Question: Write a caption explaining this figure to a reader.
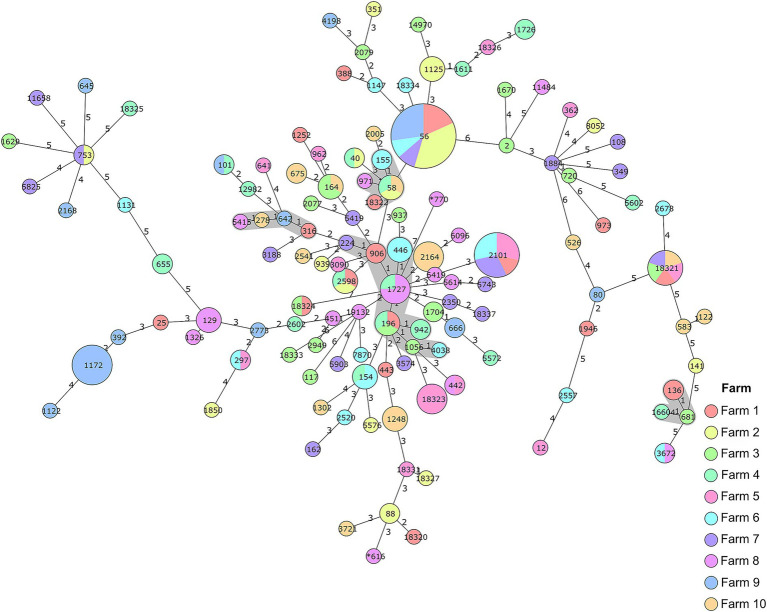
Answer: Proportion of non-wild-type isolates among 706 non-selectively obtained E. coli isolates.